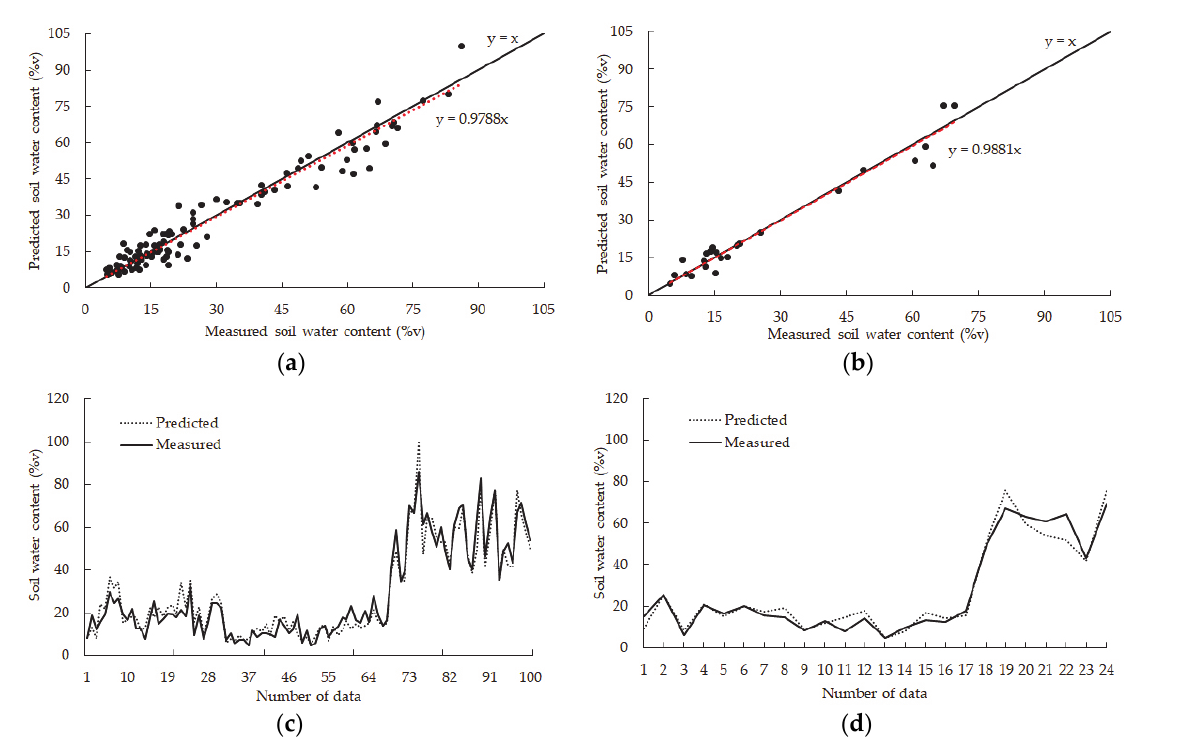
Figure 7. Fitting and plotting curves of real and computed values of soil water content: ( a ) Fitting curve of training model; ( b ) Fitting curve of testing model; ( c ) Plotting curve of training model; ( d ) Plotting curve of testing model.